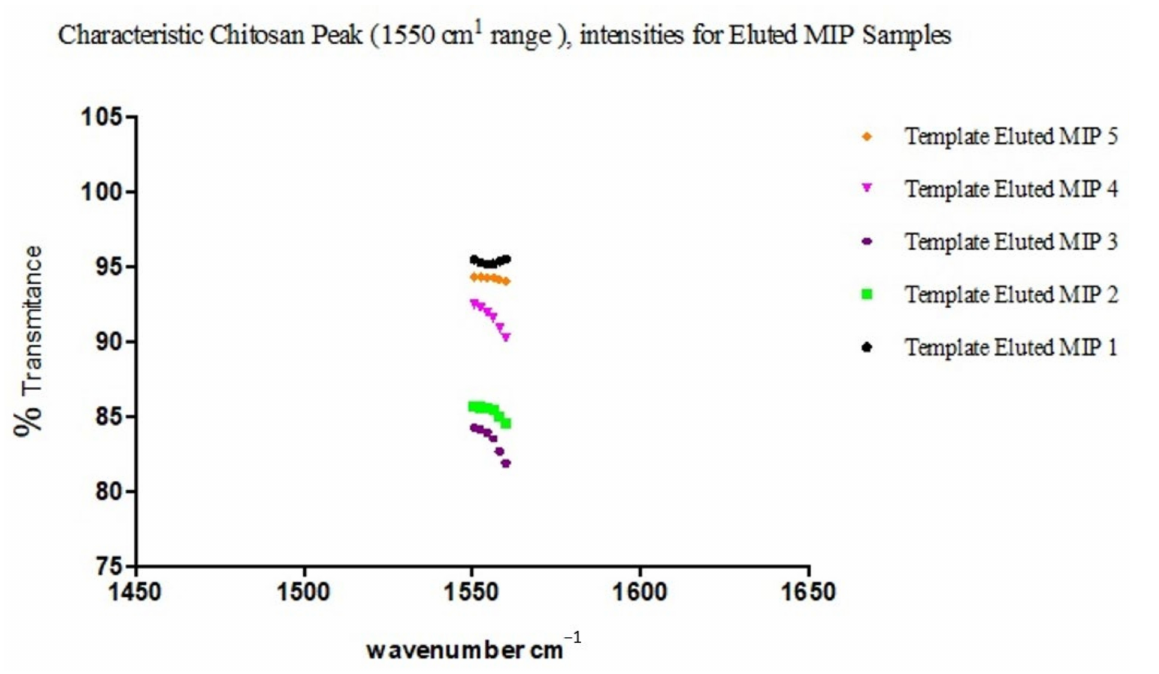
Figure 7. Characteristic peak intensities of Chitosan (1550 cm − 1 ) for the different eluted MIP